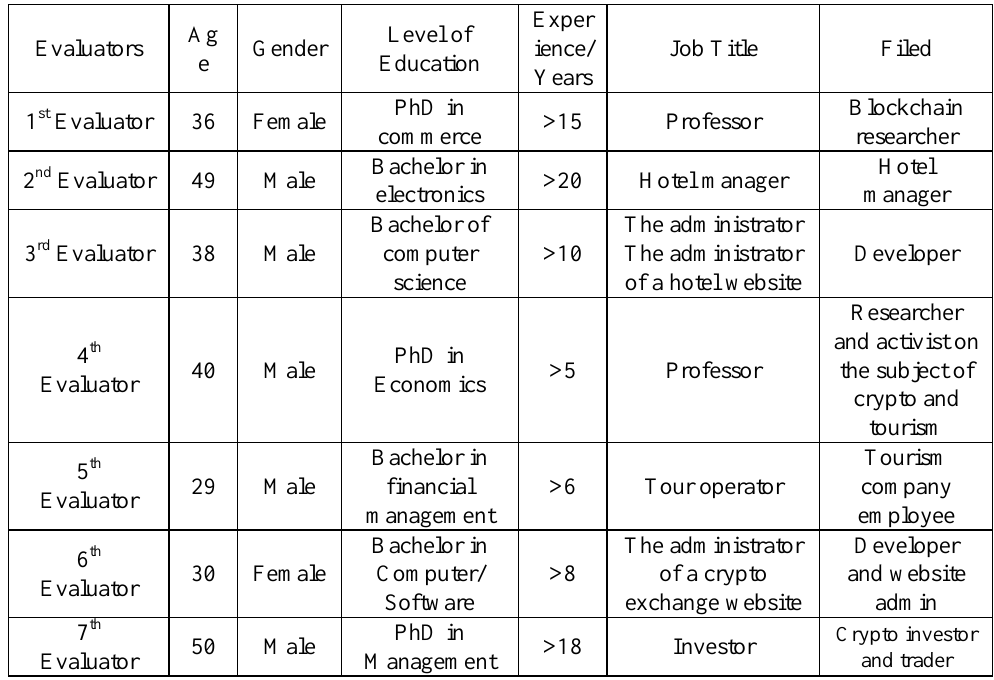
Table 3. Evaluators’